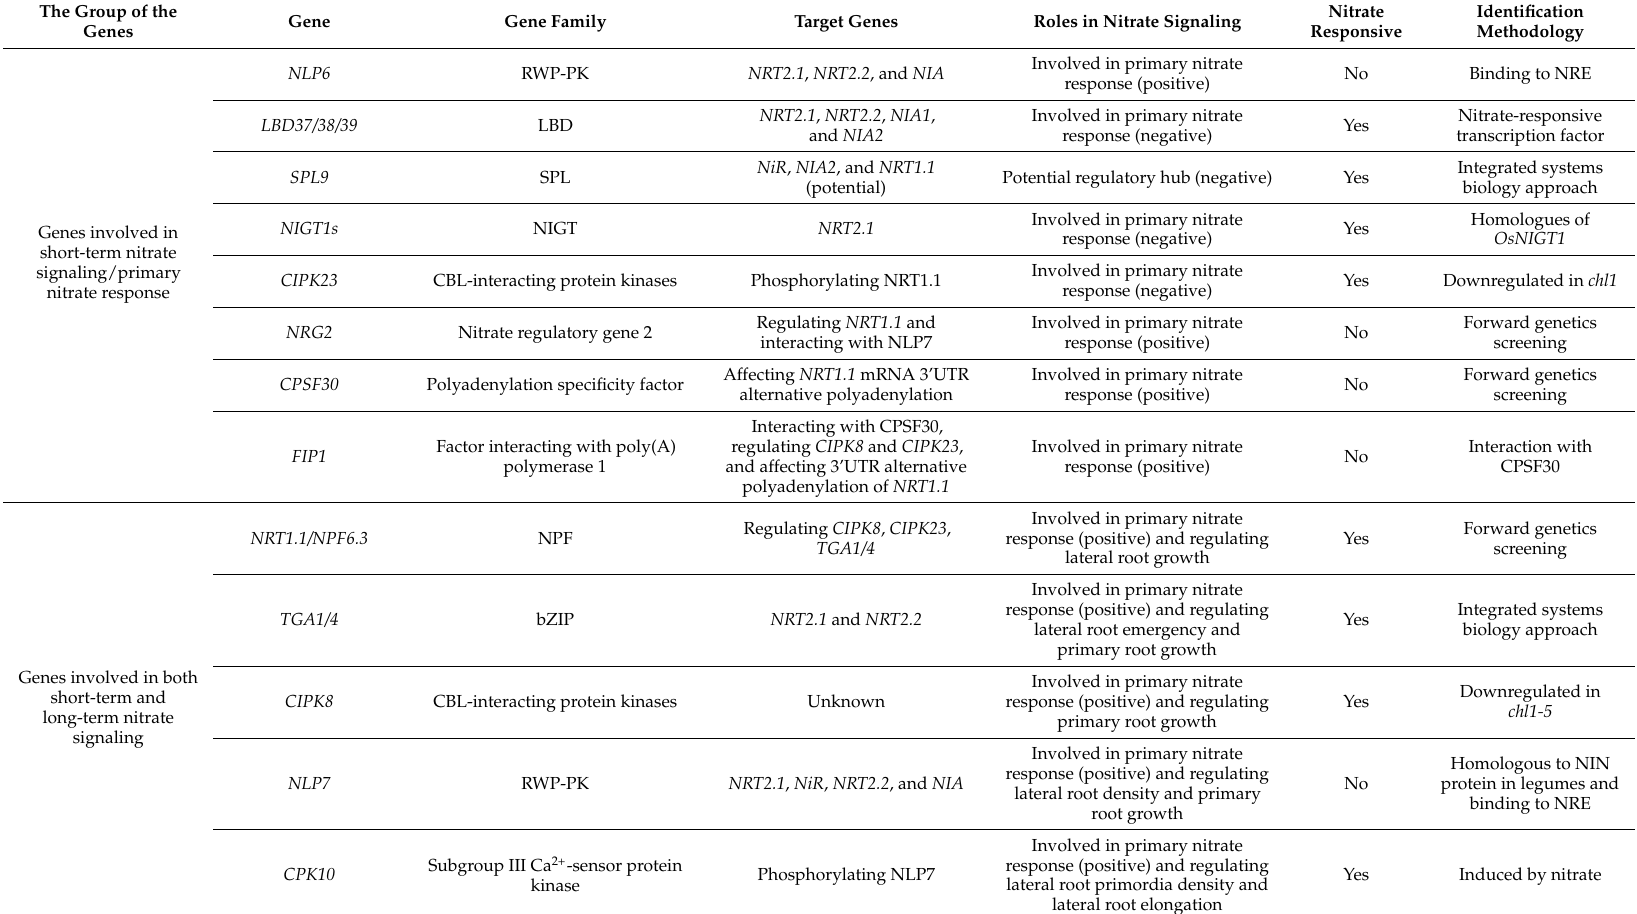
Table 1. Summary of nitrate regulatory genes in the short-term and long-term